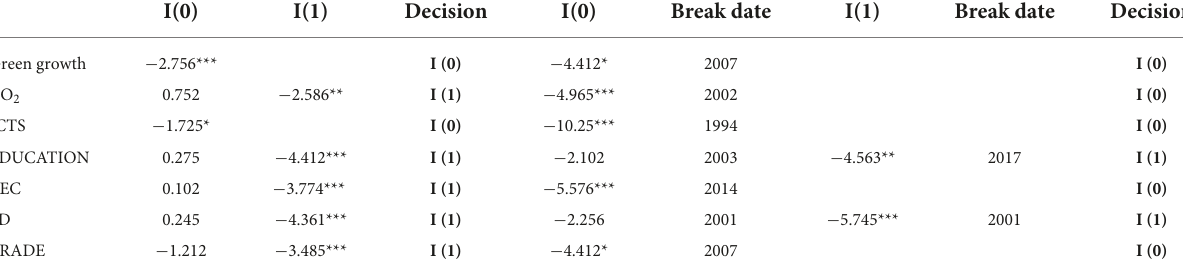
TABLE 2 Unit root test.